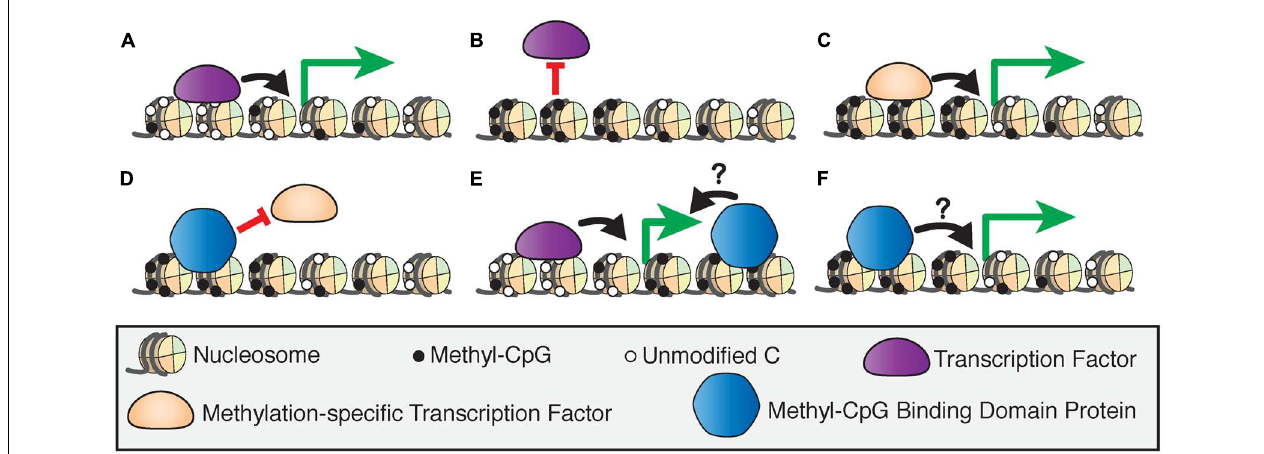
FIGURE 1 | Models of 5-methylcytosine affecting transcription factor recruitment. (A) The binding of transcription factors at hypomethylated regulatory regions drives transcriptional activation. (B) Activating transcription factors are blocked from binding hypermethylated regulatory regions, inducing transcriptional silencing. (C) Methylation-specific transcription factors bind hypermethylated regulatory regions to activate transcription. (D) Methyl-CpG binding domain (MBD) proteins can bind hypermethylated regions and block transcription factor binding to induce transcriptional silencing. MBD proteins bind to actively transcribed genes at intragenic (E) or promoter (F) sites, but the effect of this binding on transcriptional regulation is unclear.